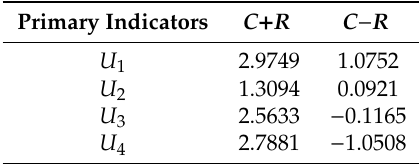
Table 2. The centrality and causality of the primary